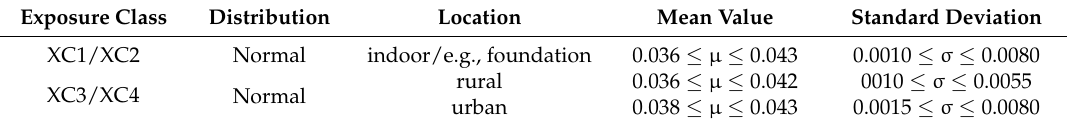
Table 3. Assumed maximum and minimum CO 2 concentrations based on a literature review